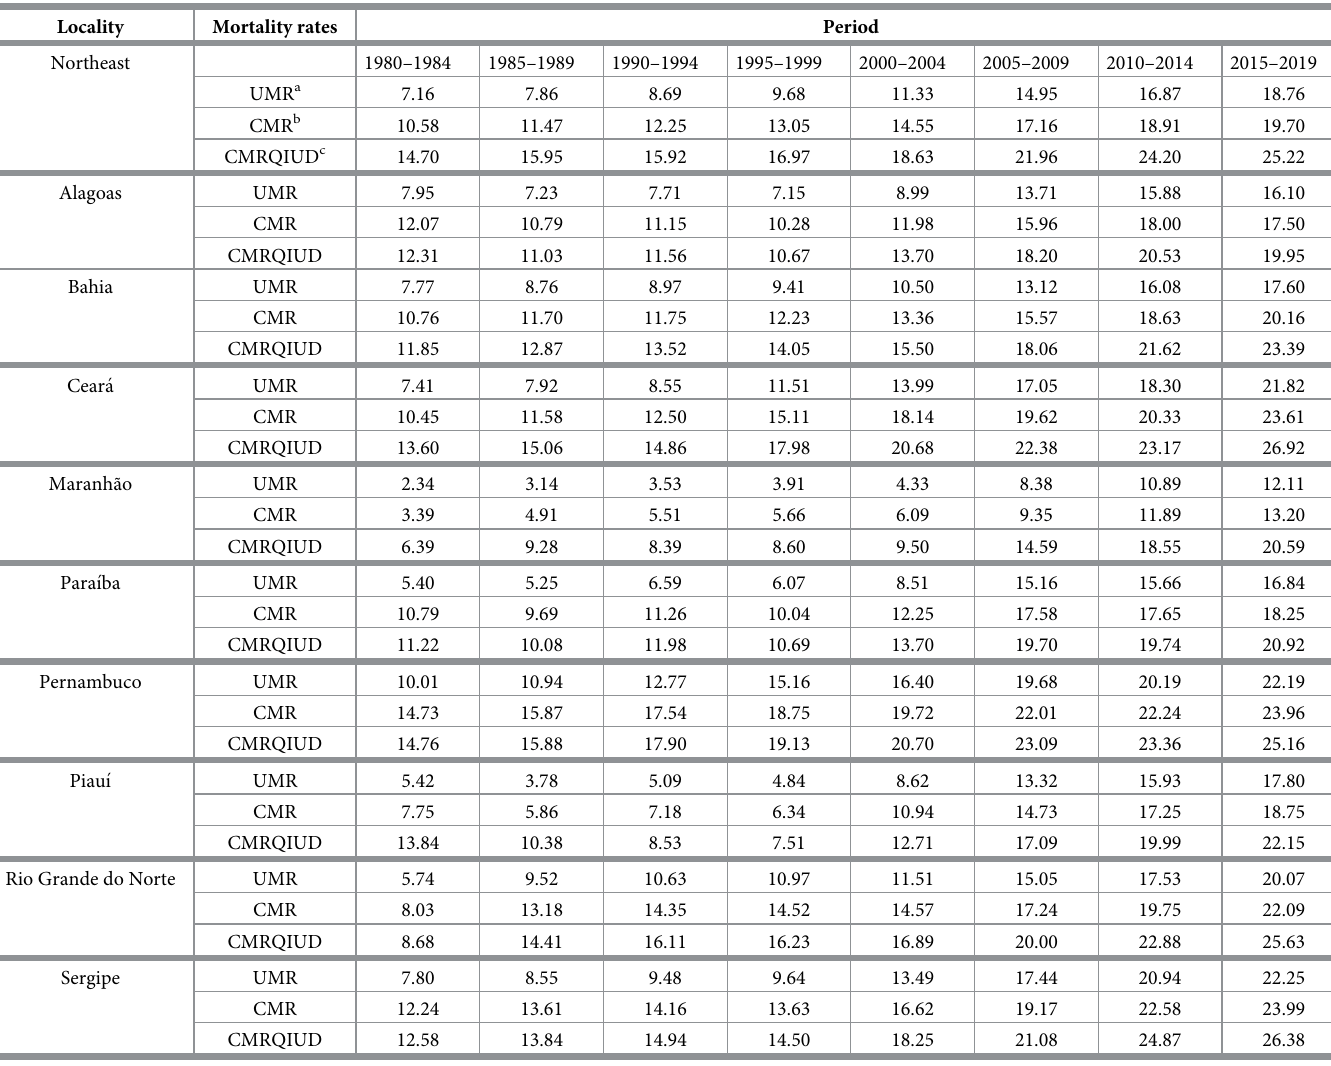
Table 4. Breast cancer mortality standardized rates (per 100,000 women) from 1980 to 2019 in the states of north-eastern Brazil. Locality Mortality rates Period Northeast